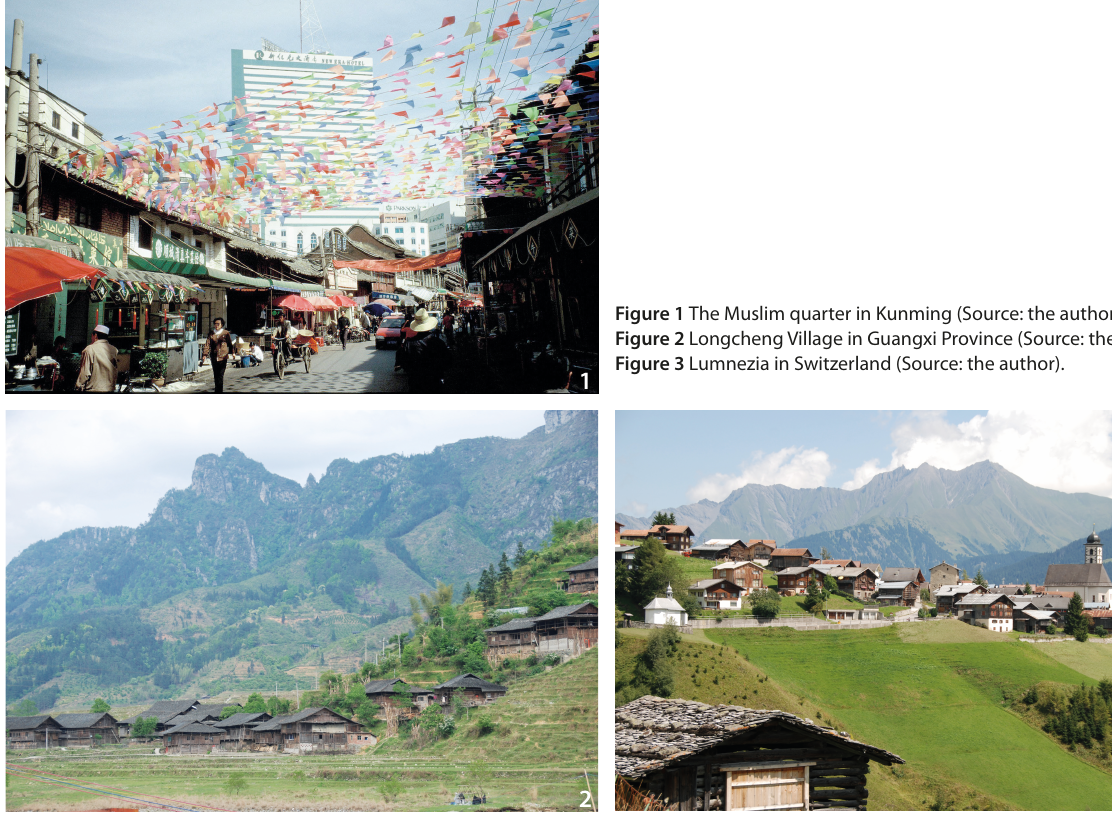
Figure 1 The Muslim quarter in Kunming (Source: the author). Figure 2 Longcheng Village in Guangxi Province (Source: the author). Figure 3 Lumnezia in Switzerland (Source: the author).